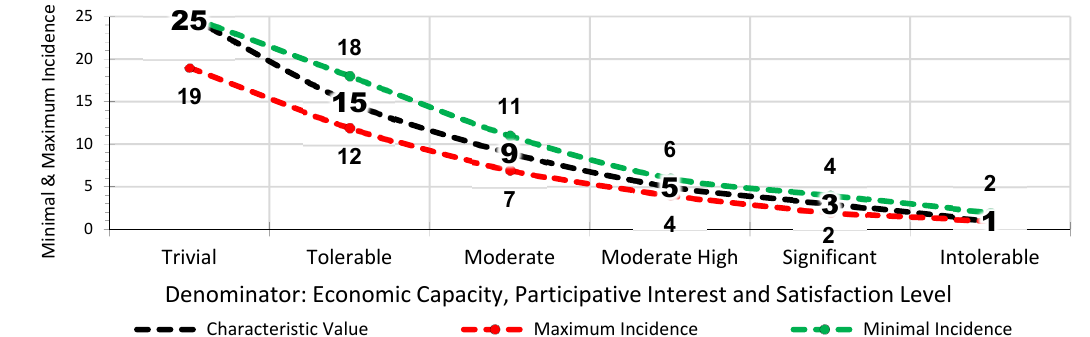
Figure 8. Cvs of Incidence of the Denominator Parameters.